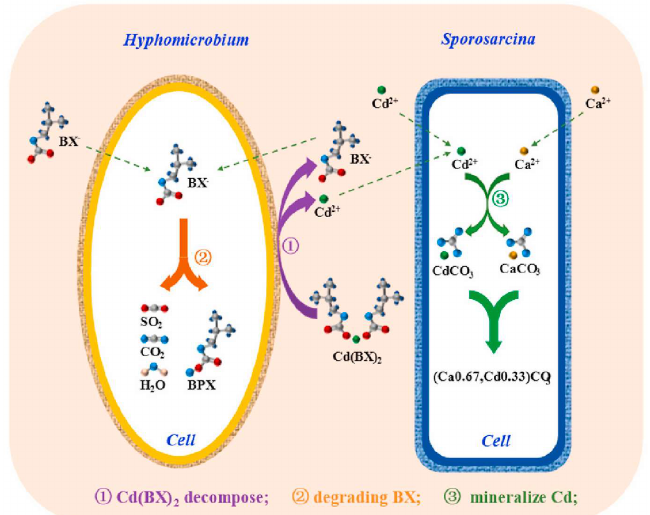
Figure 1. Degradation/biomineralization pathway sketch map (Reproduced from J. Environ. Manage. 2022, 316, 115304 with permissions from Elsevier, Netherlands) [41].